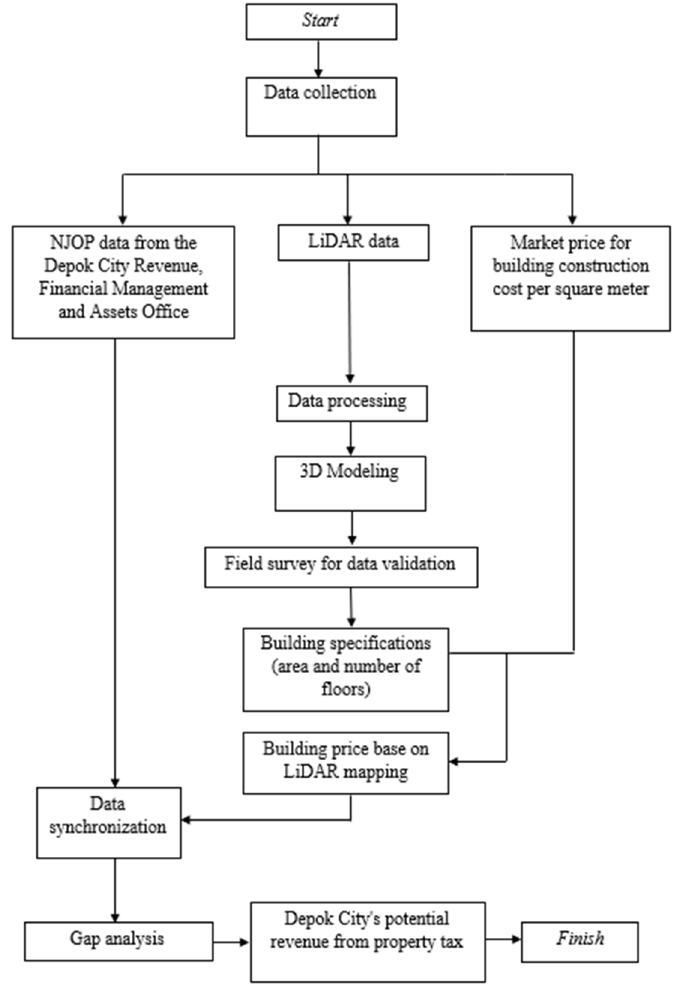
Figure 2. Study workflow.